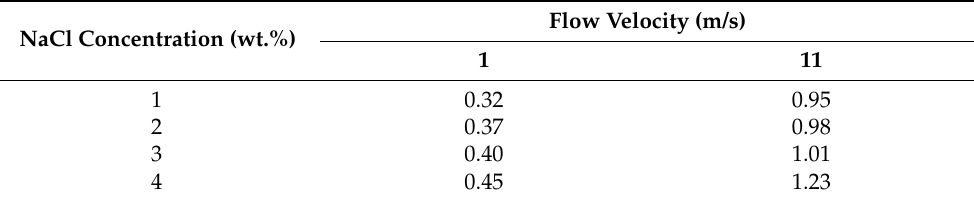
Table 6. Corrosion rate of 304L stainless steel at different concentrations (mm/a). NaCl Concentration